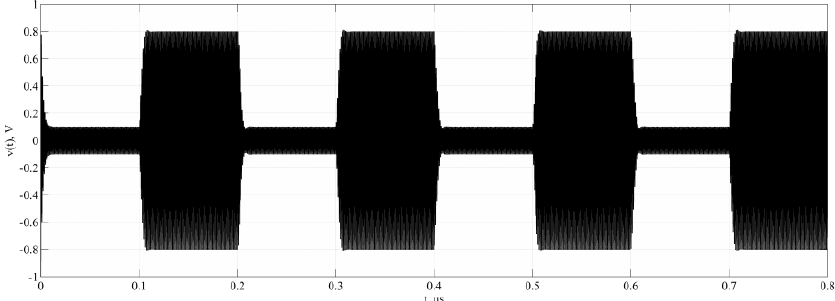
Fig. 3. The t ime-domain representation for the test sequence with ASK